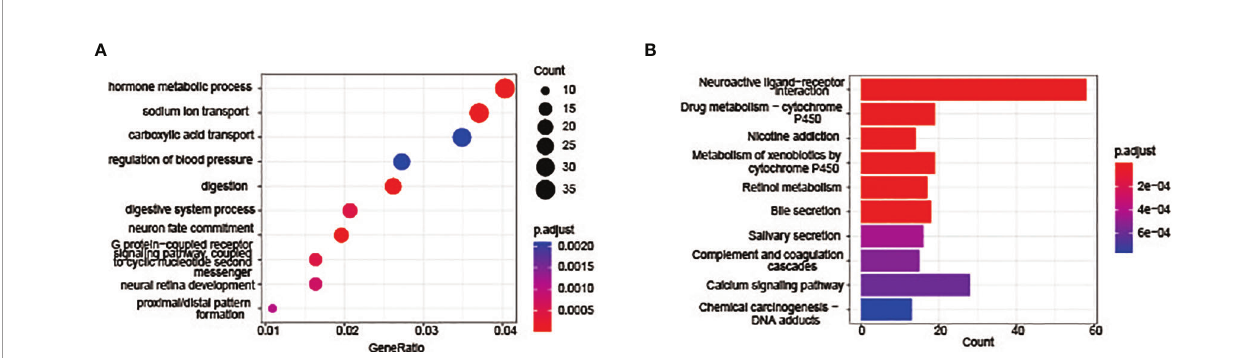
FIGURE 4 | Functional enrichment and pathway analysis results of differentially expressed genes. (A) Top 10 enriched GO terms annotated in biological process. (B) Top 10 KEGG pathways of the differentially expressed